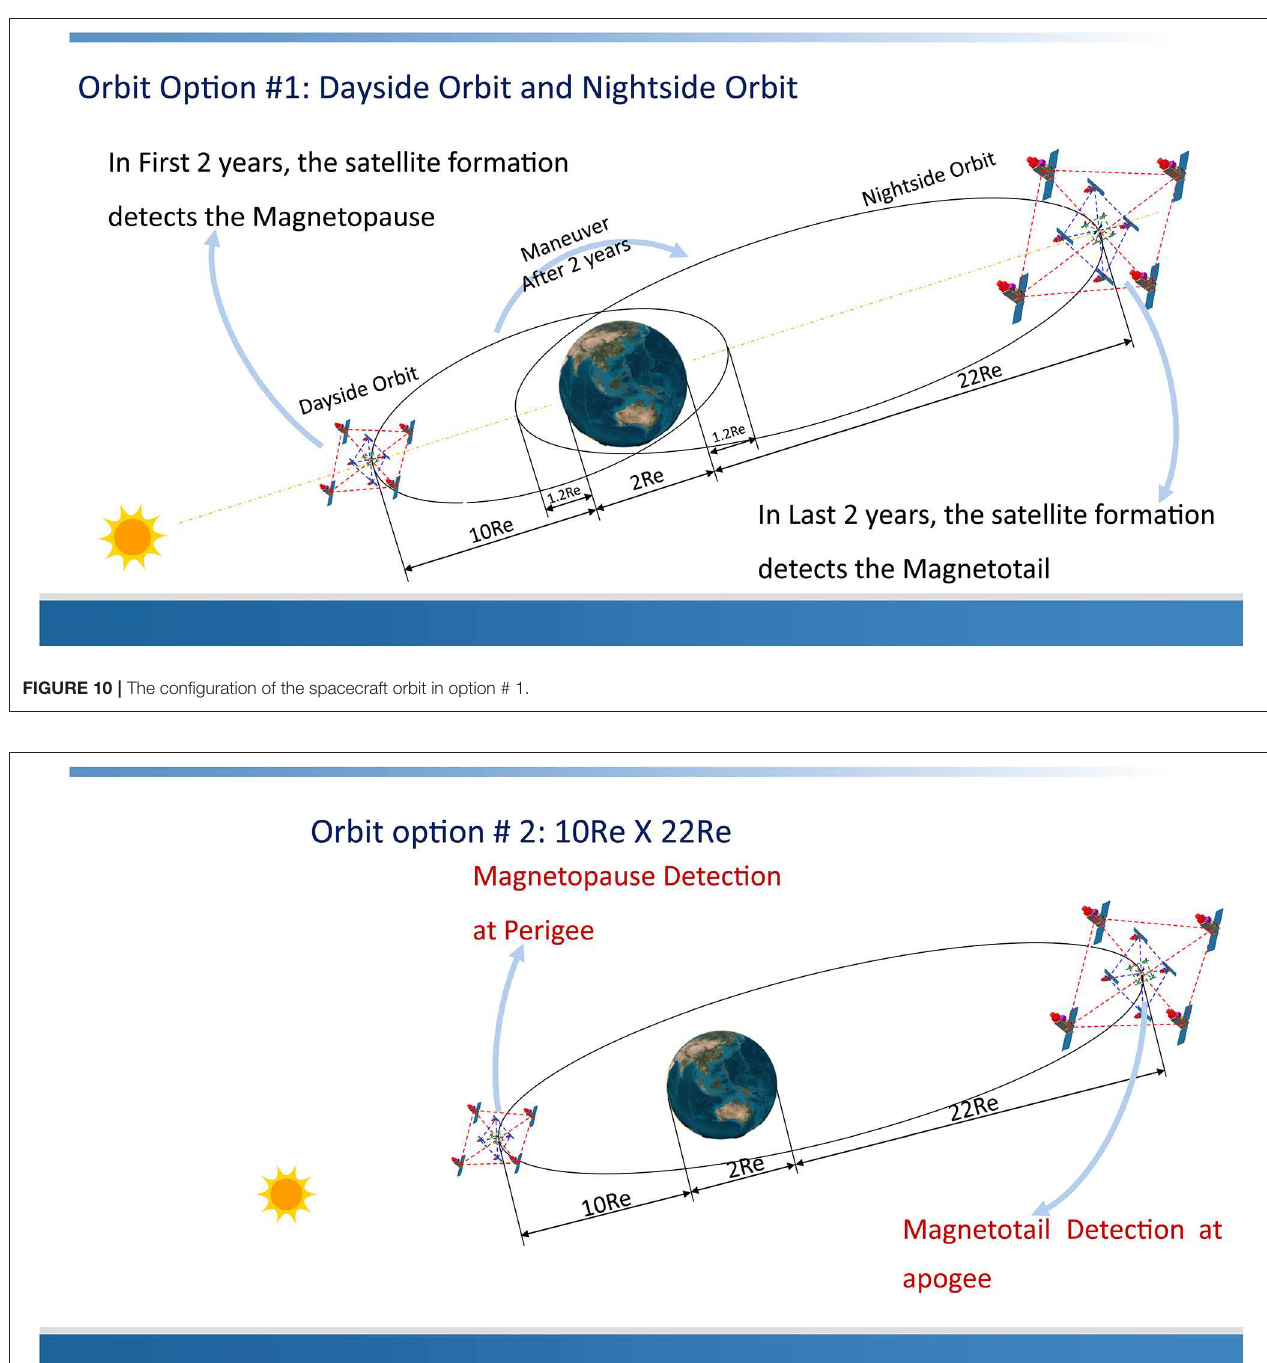
spacecraft dimensions, after unfolding solar panels, are 8,964 mm when the spacecraft reaches the nominal orbit. The design of the 2,554 mm 2,801 mm. CubeSats is shown in the middle top of the figure. The dimension × × The spacecraft product tree is presented in Figure 9 . of each CubeSat before (after) the deployment is 484 mm × The main spacecraft includes the Platform (PLF) 225 mm 226 mm (484 mm 1,025 mm 226 mm). The main × × ×